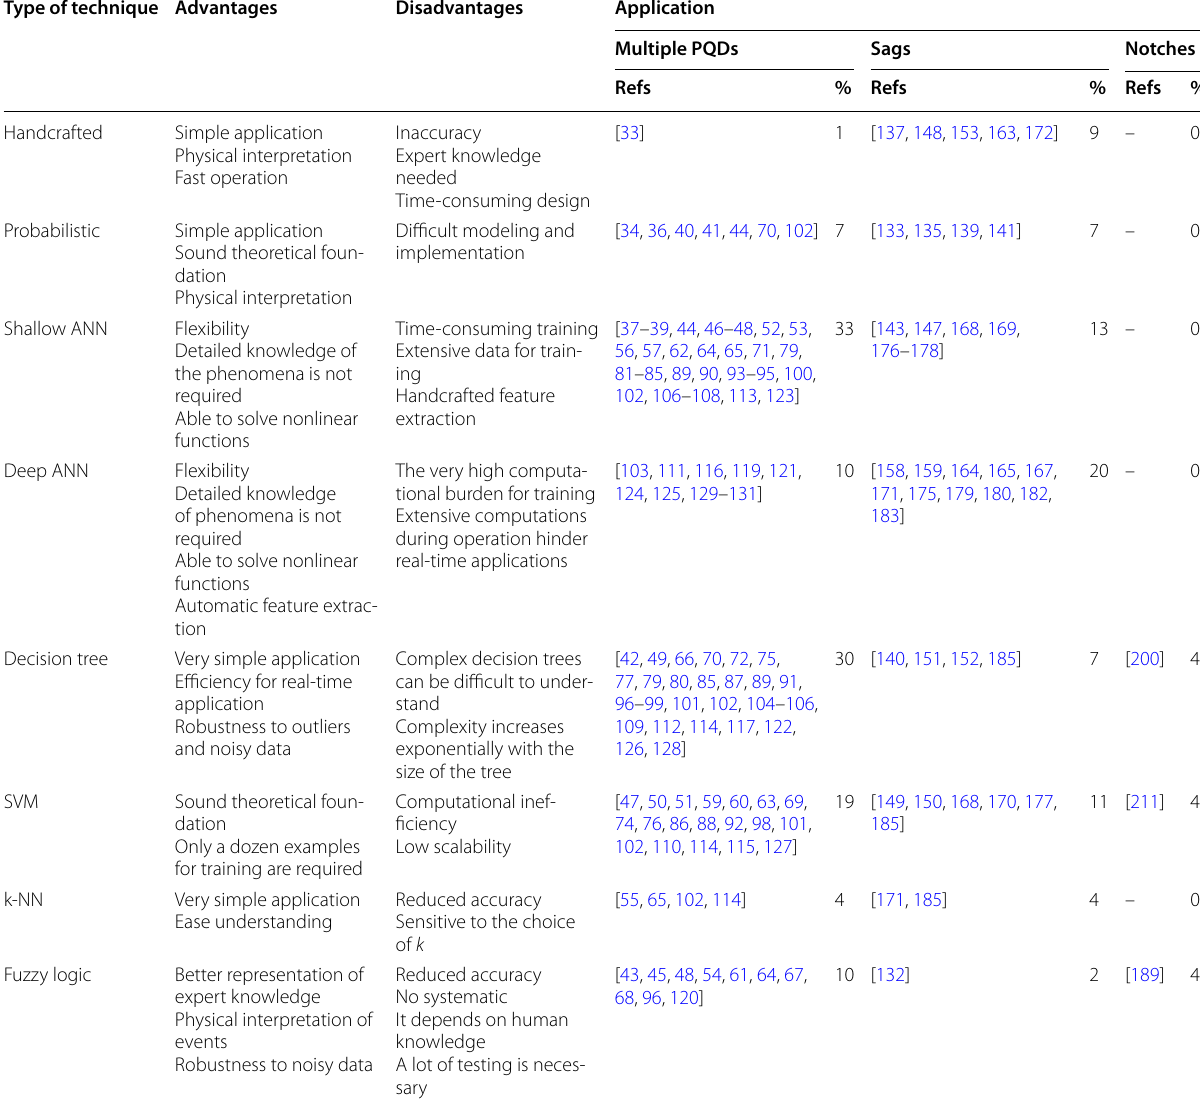
Table 11 Summary of classification techniques Type of technique